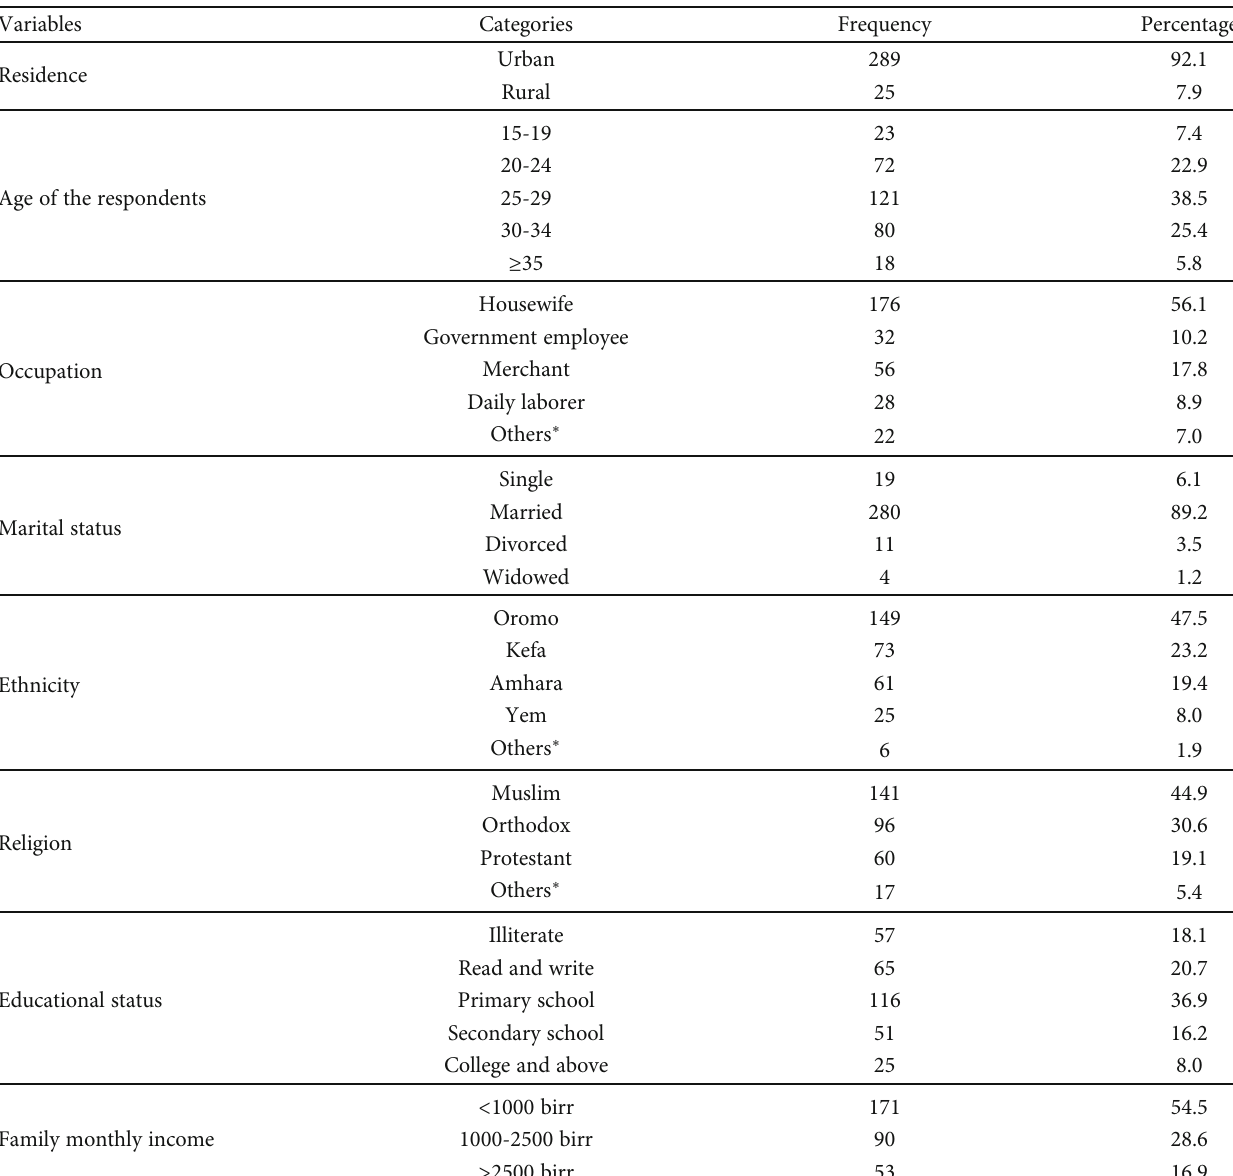
Table 1: Sociodemographic characteristics of respondents in Kochi Health Center, Jimma town, southwest Ethiopia,